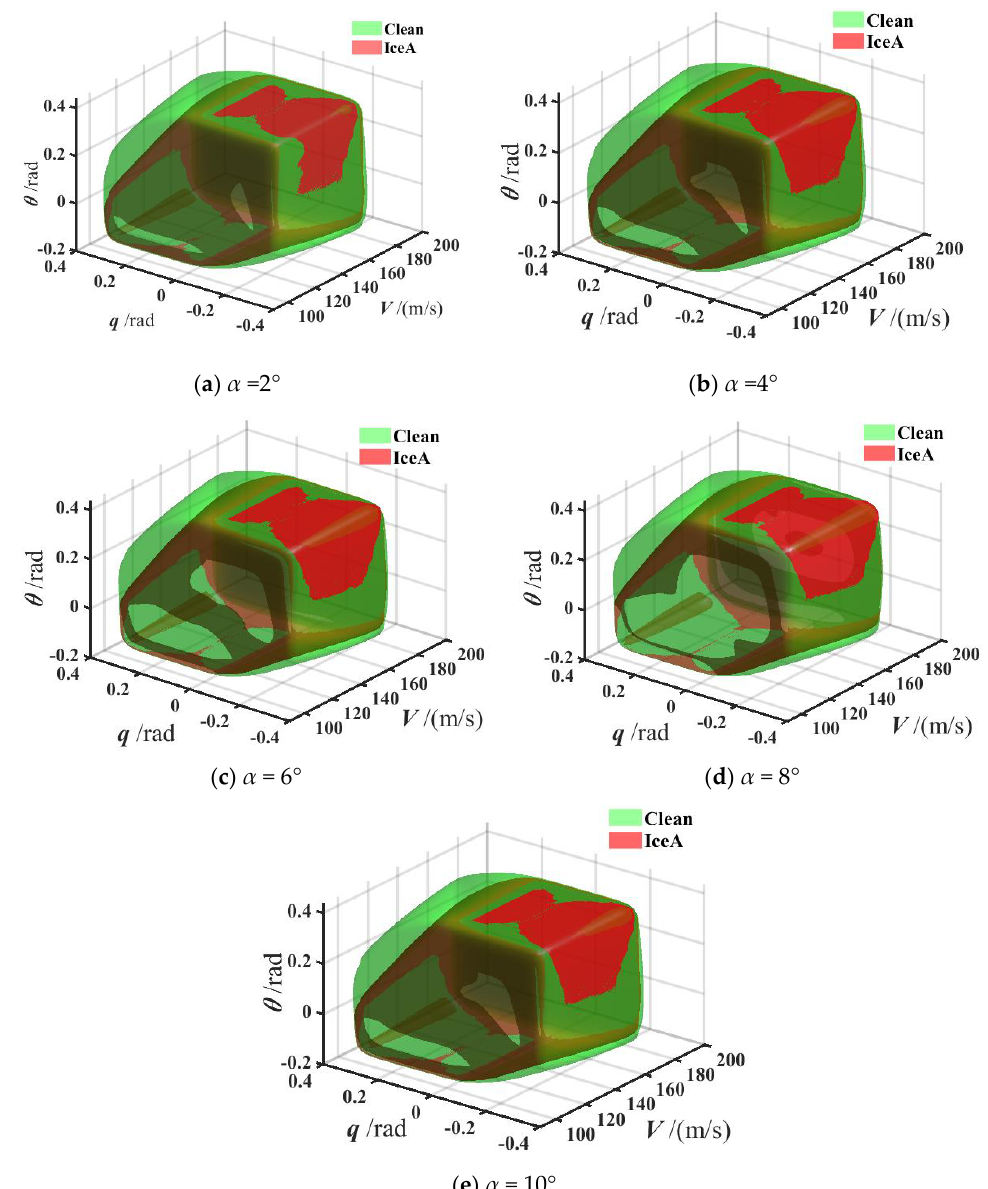
Figure 5. Comparison of flight safety envelope curve between clean configuration and heavy icing configuration under different attack angles. ( a ) α =2°, ( b ) α =4°, ( c ) α = 6°, ( d ) α = 8°, ( e ) α = 10°